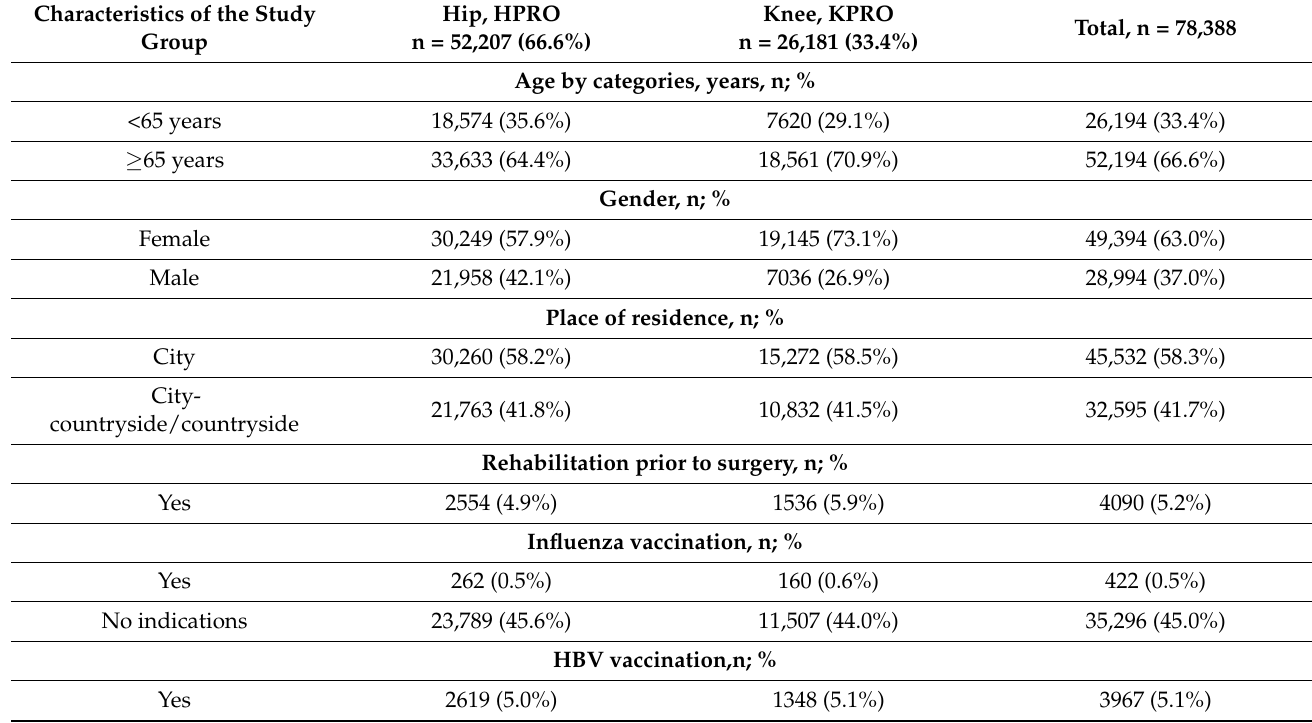
Table 1. Characteristics of the population for primary surgery.